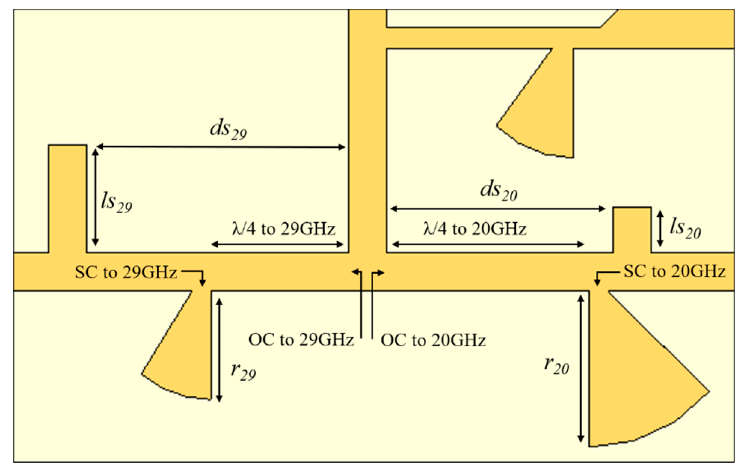
Figure 8. Microstrip feeding structure of the dual-frequency antenna using two stop-band filters at each frequency (open circuit, or OC: radial strub + λ /4 line).